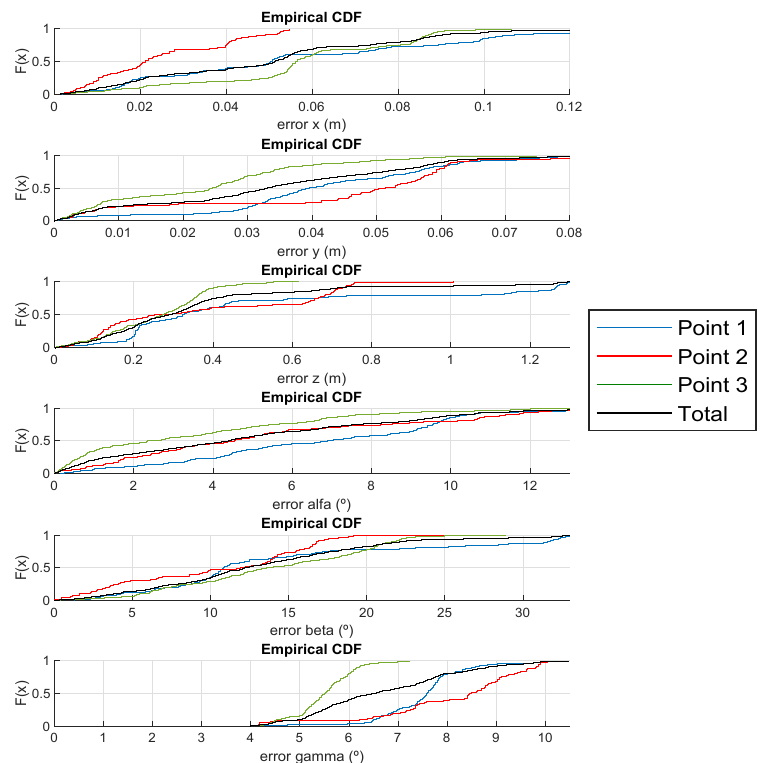
Figure 13. CDF of the absolute errors for every experimental point at z = 0m for γ = {0 ◦ , 120 ◦ , 210 ◦ and 300 ◦ } with the IPPE